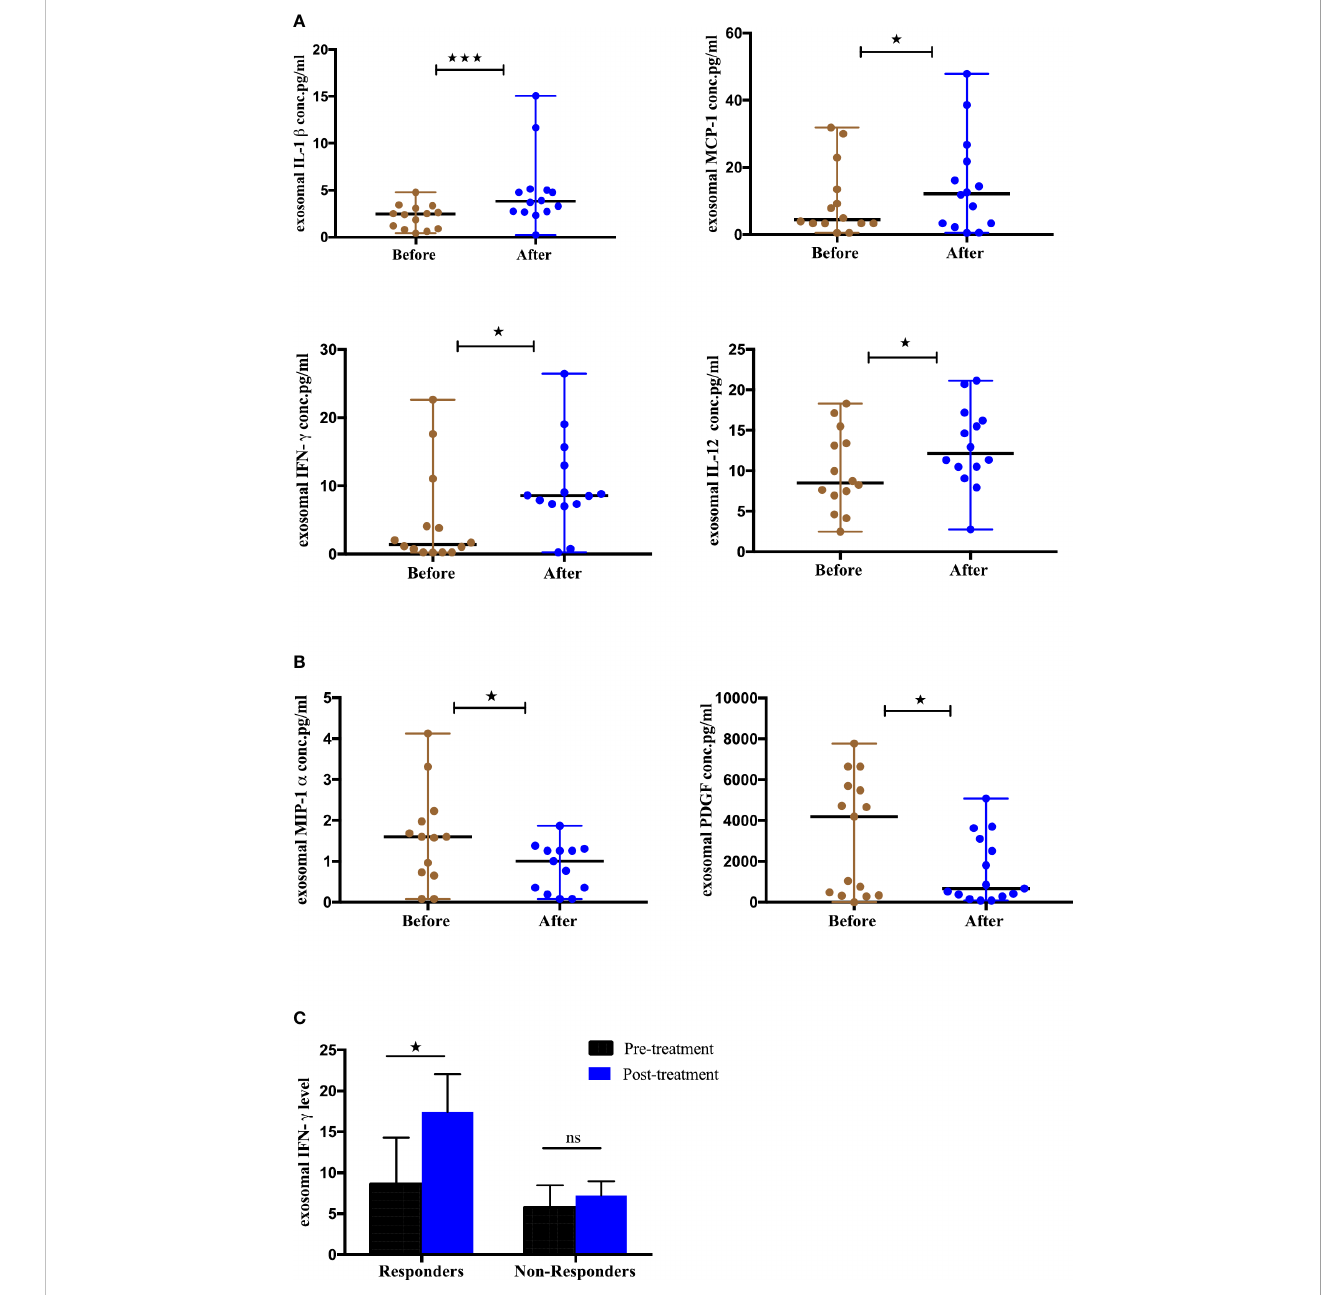
FIGURE 9 Differential Expression of cytokines from serum-derived exosomes pre- and post-ICI therapy and clinical outcome, (A) Signi fi cantly upregulated exosomal cytokines and (B) Signi fi cantly downregulated exosomal cytokines from NSCLC patients before and after anti-PD-1/PD-L1 checkpoint blockade immunotherapy. (C) Association of change in exosomal cytokines in responding and non-responding patients (responders, n=7; non- responders=8. Wilcoxon matched-pairs signed-rank test (*p<0.05, **p<0.01,